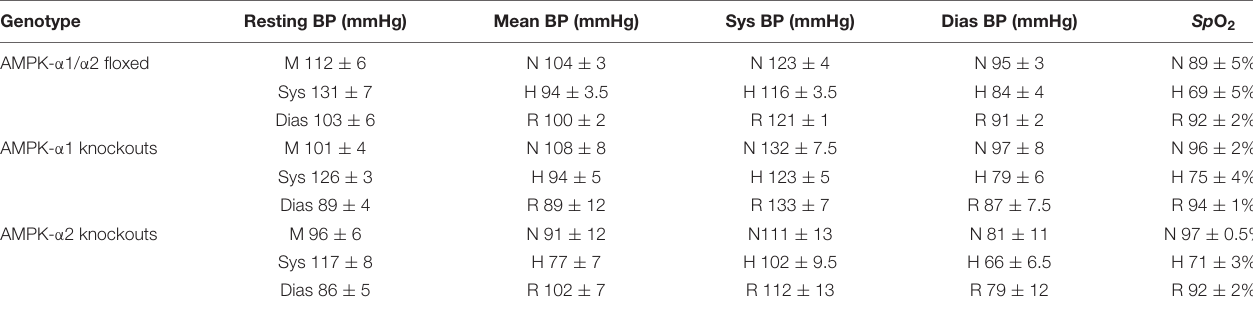
TABLE 2 | Means ± SEM of values obtained by tail cuff blood pressure measurements and percentage changes in arterial Sp O 2 before, during, and after exposures to hypoxia (8%O 2 ) across all